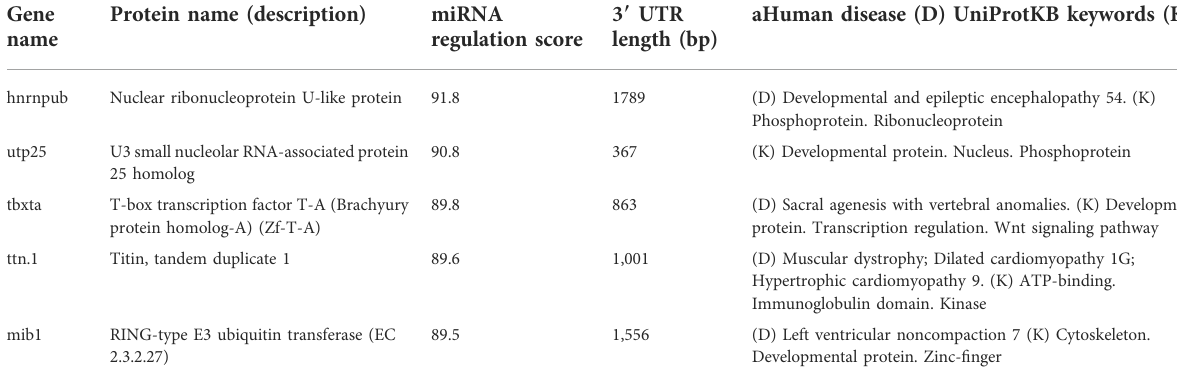
TABLE 4 Zebra fi sh miRNA